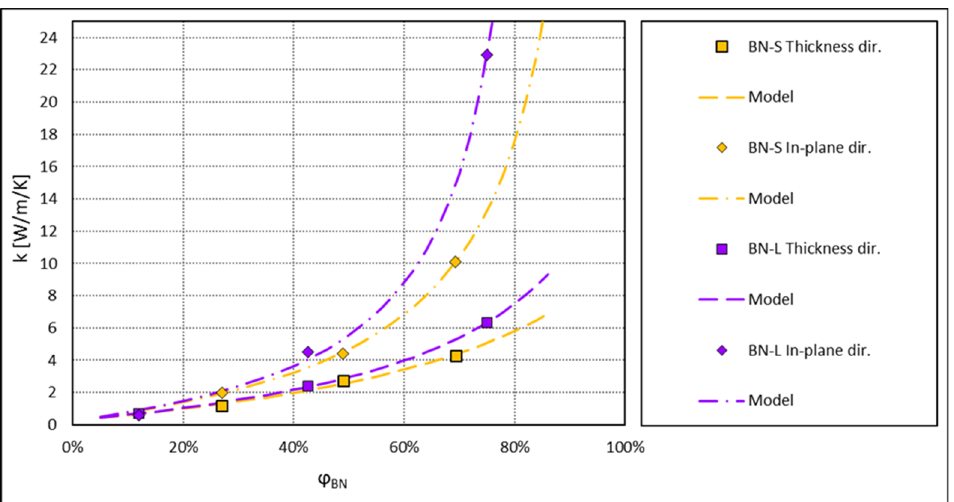
Figure 11. Thermal conductivity of composites with cellulose-BN core-shell fillers of Reference [19]. Lines show the results of model calculations, symbols are measured values: ( a ) Thermal conductivity vs. the core-shell filler volume content in the system, as calculated according to Equation (6). ( b ) Thermal conductivity vs. the absolute volume fraction of BN in the system, as originally presented in Reference [19].